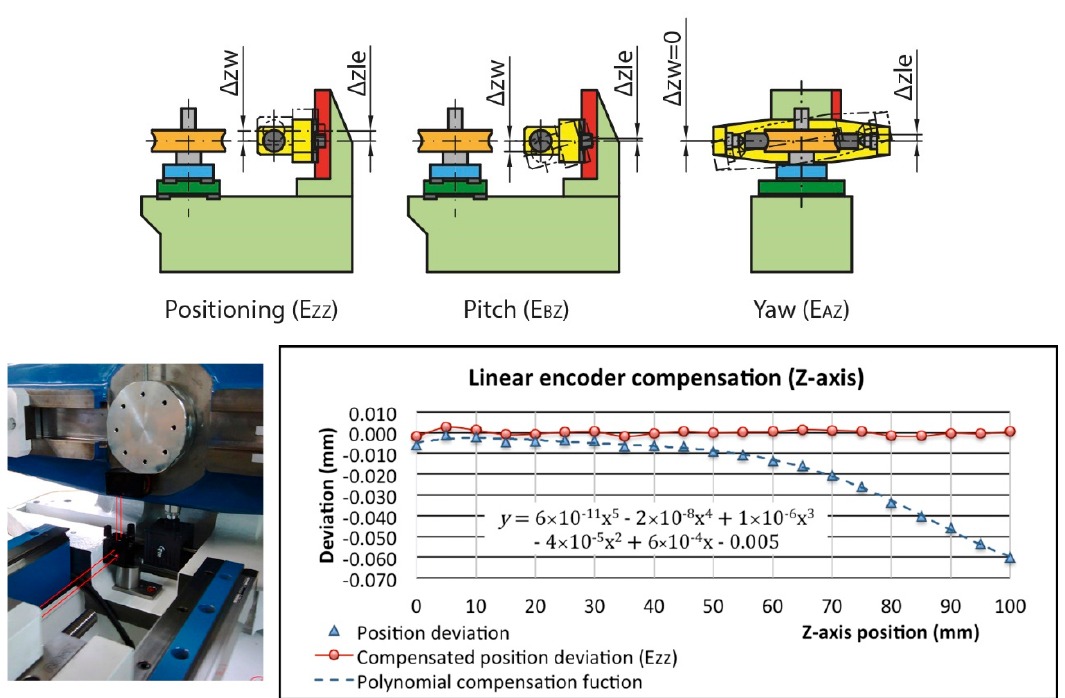
Figure 10. Linear encoder (Z-axis) numerical compensation (height position): errors, optic location